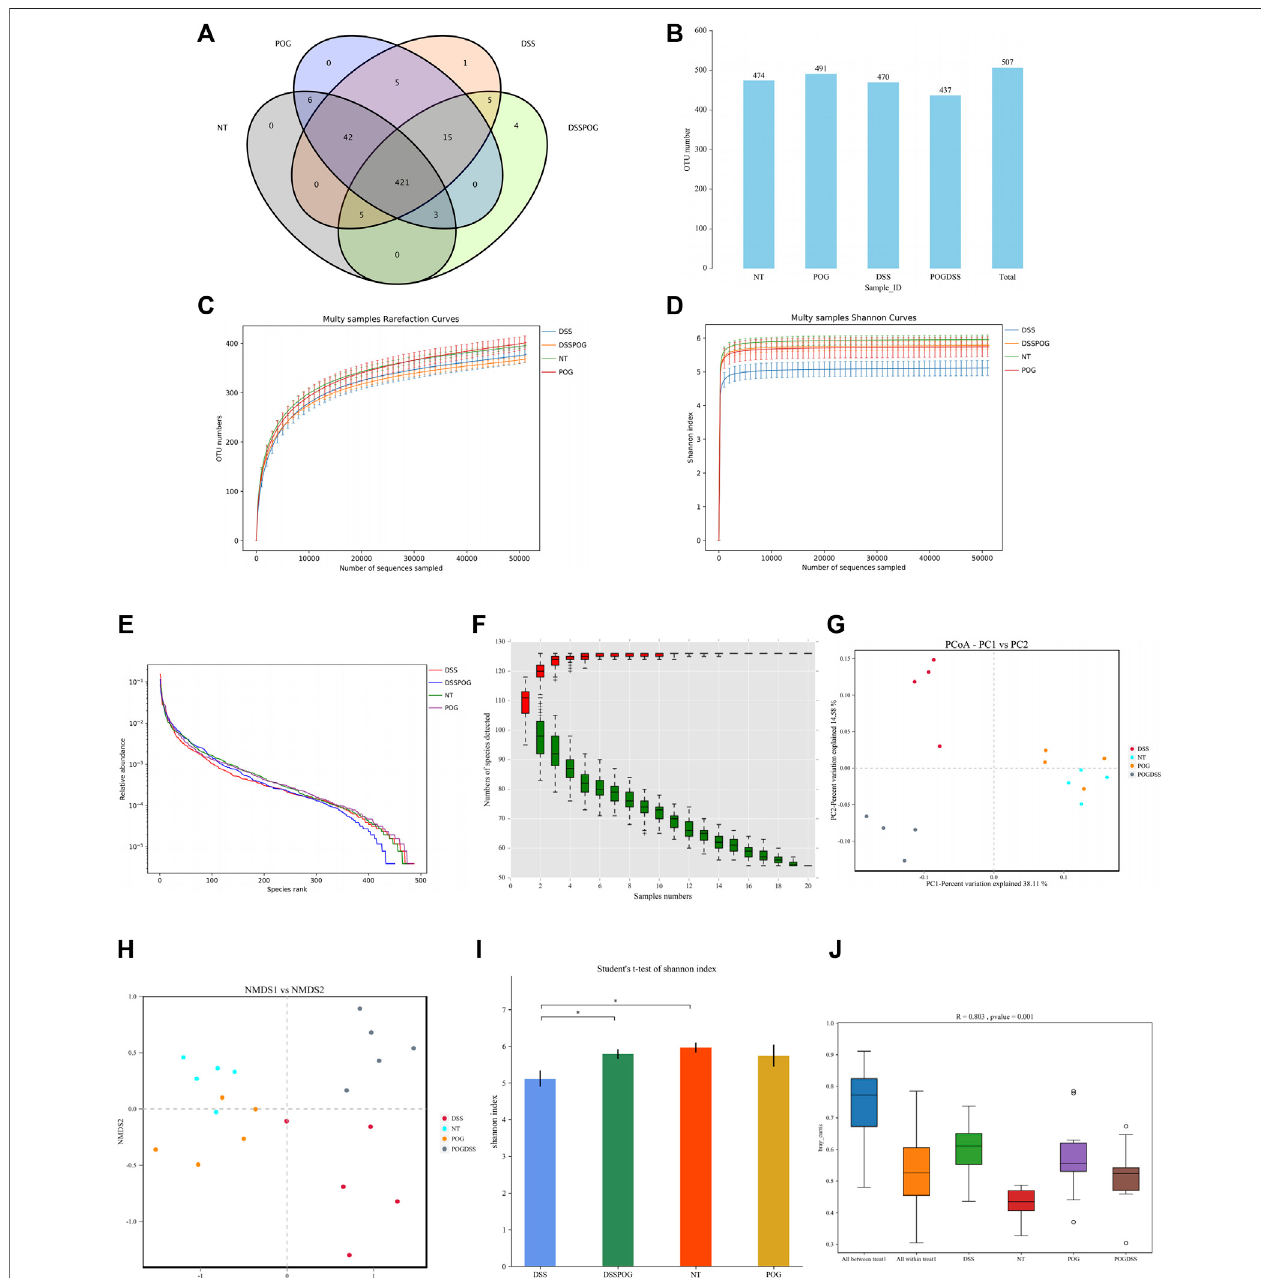
FIGURE 5 | Role of POG in the intestinal fl ora. (A) Characteristic Venn diagram between groups. (B) Distribution of UTO numbers in each group (C) Dilution curve. (D) Shannon curves. (E) Rank and curve. (F) Species accumulation curves. (G) PCoA score chart. (H) NMSD score chart. (I) Alpha diversity index difference between groups histogram. (J) ANOSIM analysis box